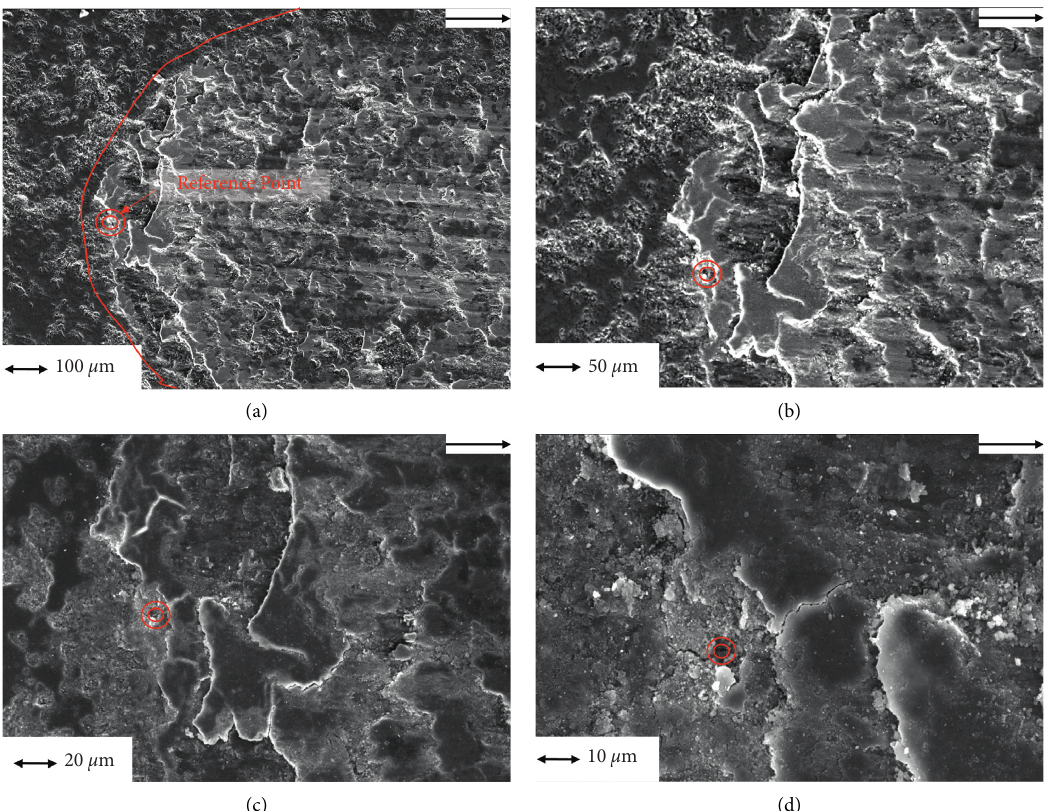
Figure 10: SEM micrographs of the shale surface at the area of first sliding (arrows show the direction of relative sliding). (a) × 100. (b) × 200. (c) × 300. (d) × 1000.